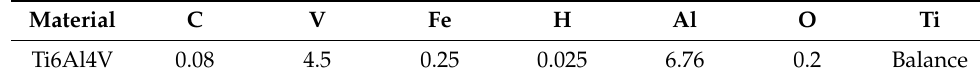
Figure 1. Schematic of the damaged substrates with triangular ( a ) and rectangular ( b ) slots; schematic of the scanning layers and tracks in the damaged substrates with triangular ( c ) and rectangular ( d ) slots. Table 1. Chemical composition of the target materials